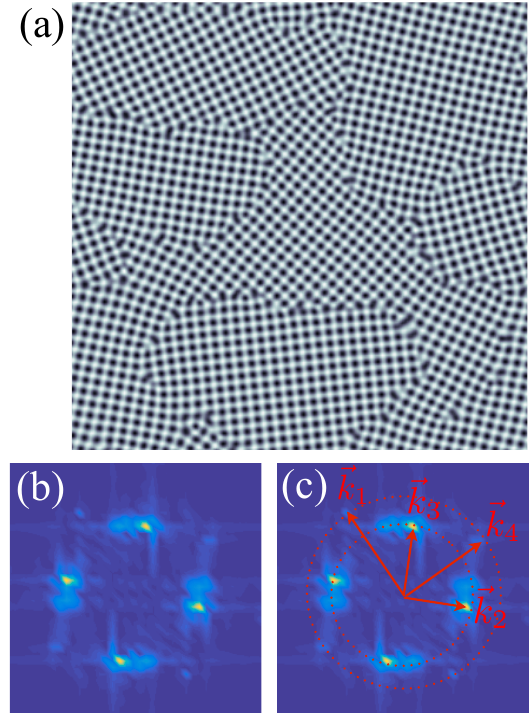
Fig. 8: (a) Gray-scale plot of u ( x, y, t ) at time t = 25000 , resulting from numerical simulations of the system (7). The parameter values are P = 1 . 1 , H = 2 . 2 , L = 4 . 7 , α 1 = α 2 = 0 , β 1 = − 3 , β 2 = 3 , β 3 = β 4 = 1 , and β 5 = β 6 = − 5 . The spatial domain is − 120 ≤ x, y ≤ 120 . (b,c) the Fourier transform of a portion of the surface u ( x, y, t ) at time t = 25000 . The domain in wavevector (cid:126)k = ( k − 0 . 8 ≤ k ≤ 0 . 8 . The x , k y ) -space is x , k y wavevectors (cid:126) k 1 , . . . , (cid:126) k 4 are marked in panel (c).